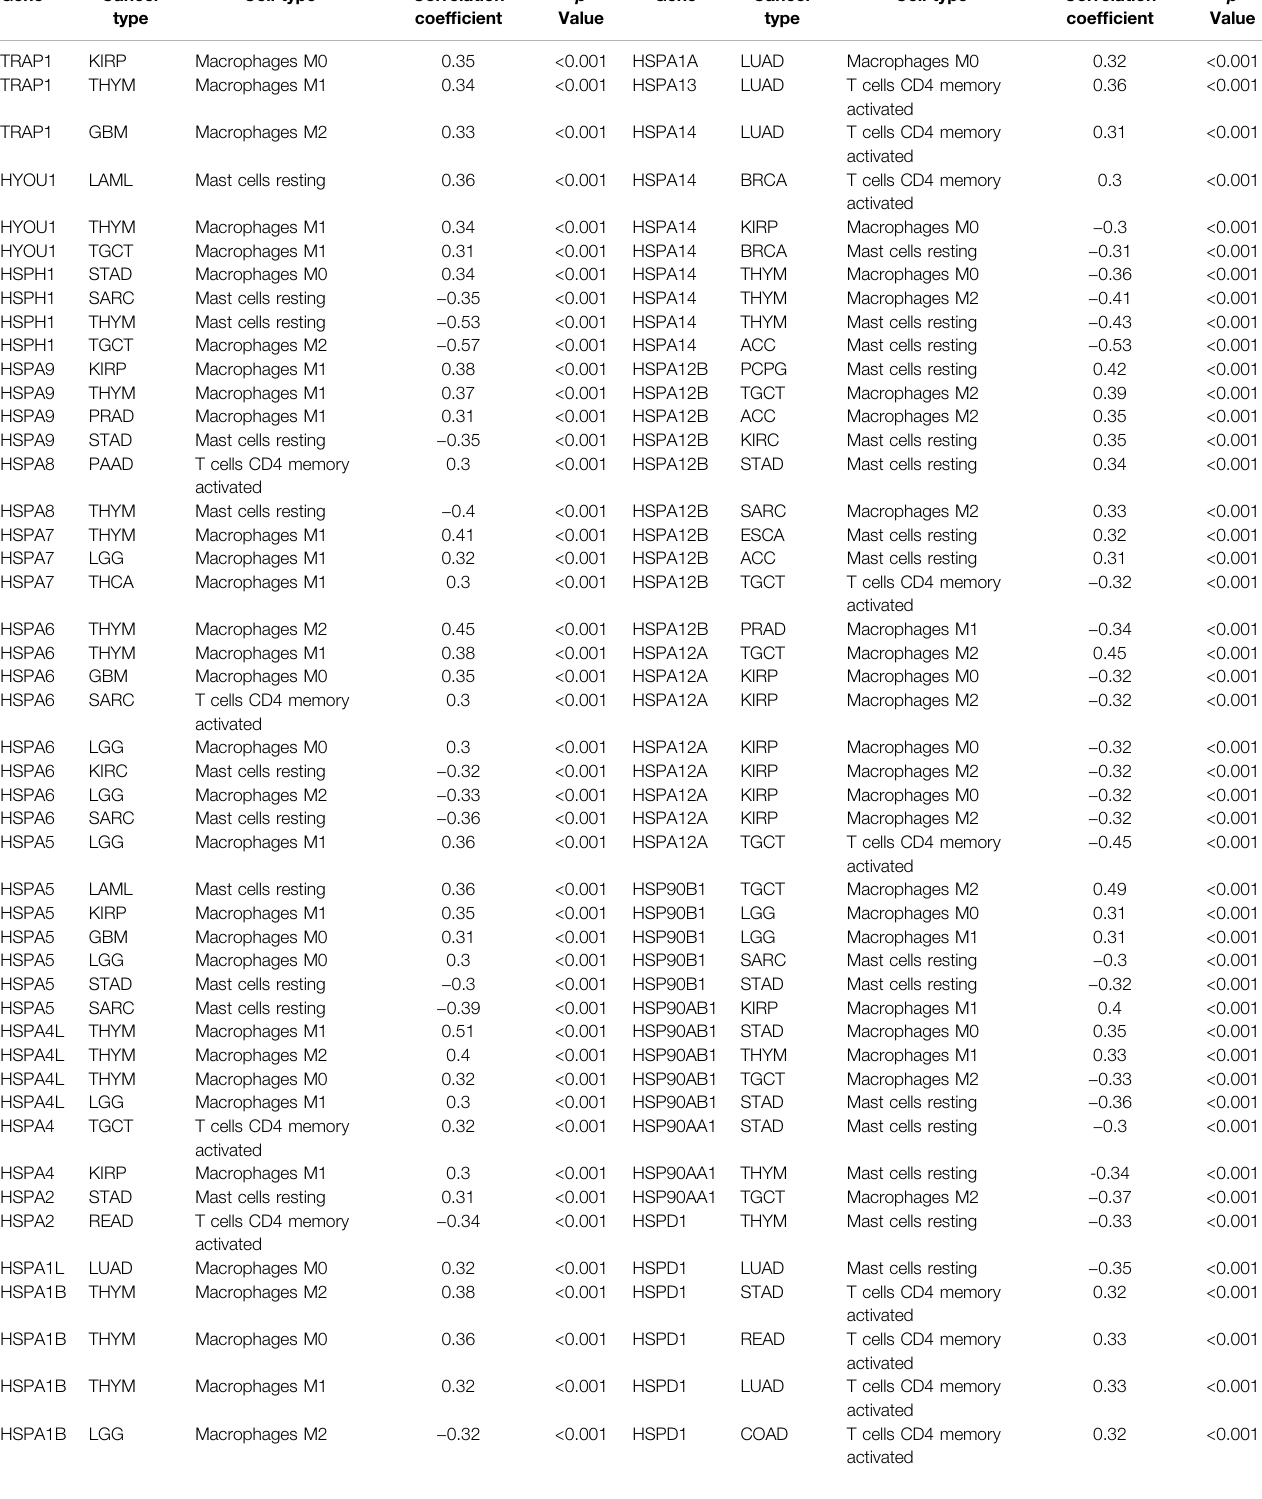
TABLE 3 | The relationships between heat shock protein expressions and immune cell in fi ltration in pan-cancer.